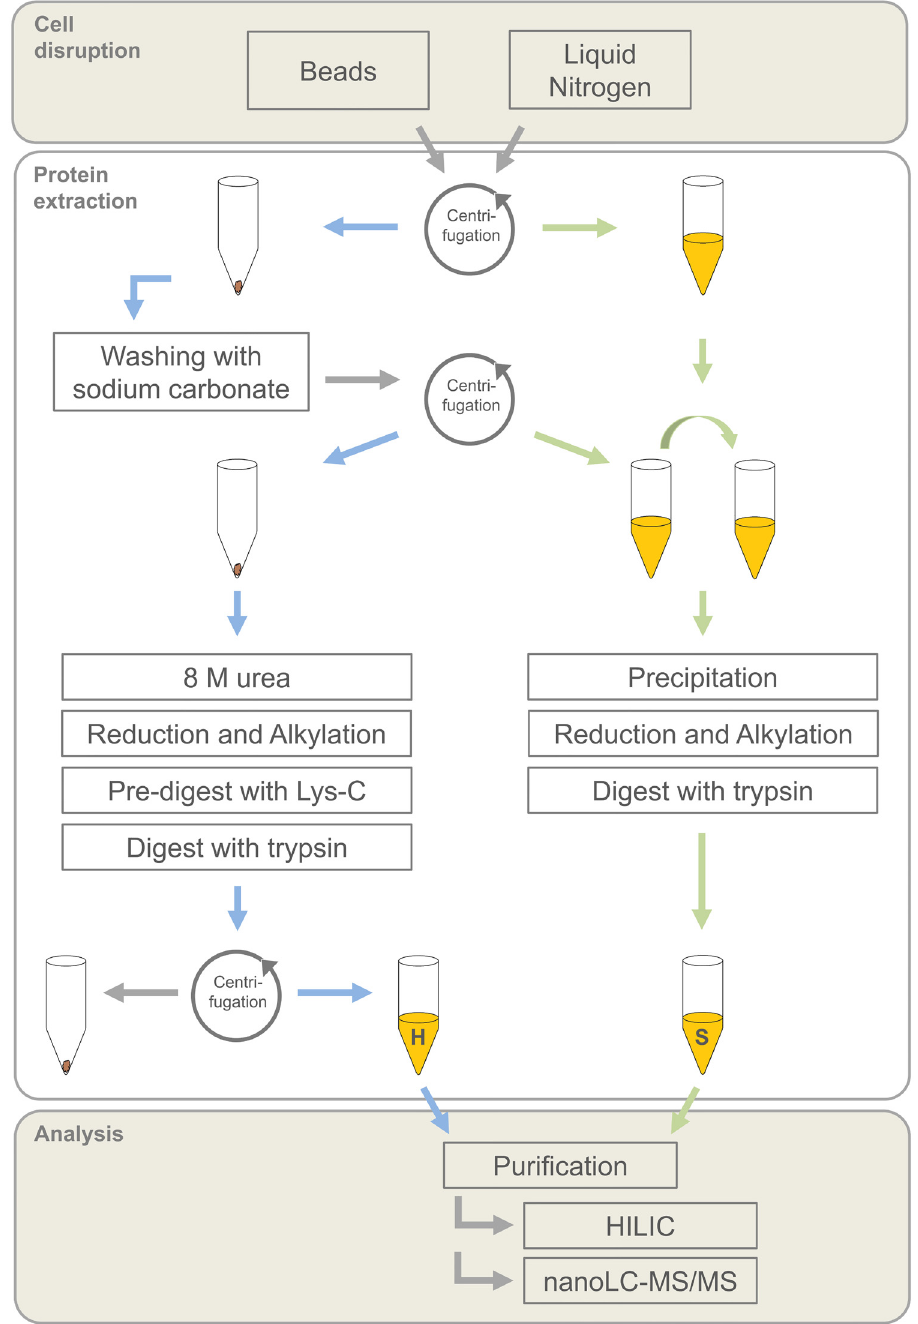
Fig 2. Overview of protein extraction for proteome analysis. Two different cell disruption methods were compared with respect to the number of protein groups identified using nano-LC-MS/MS. An additional focus was set on the solubilisation of the hardly soluble protein fraction (H) beside the soluble protein fraction (S).